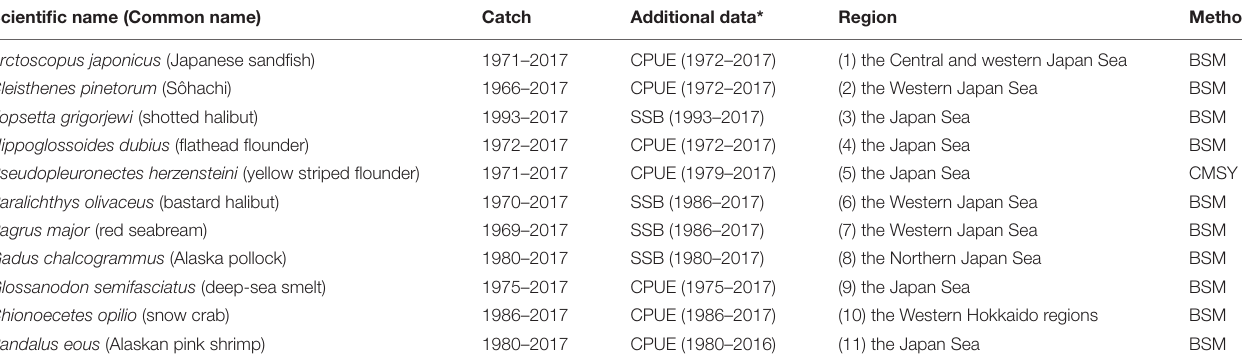
TABLE 1 | Summary of catch and CPUE data of 11 exploited populations in the Japan